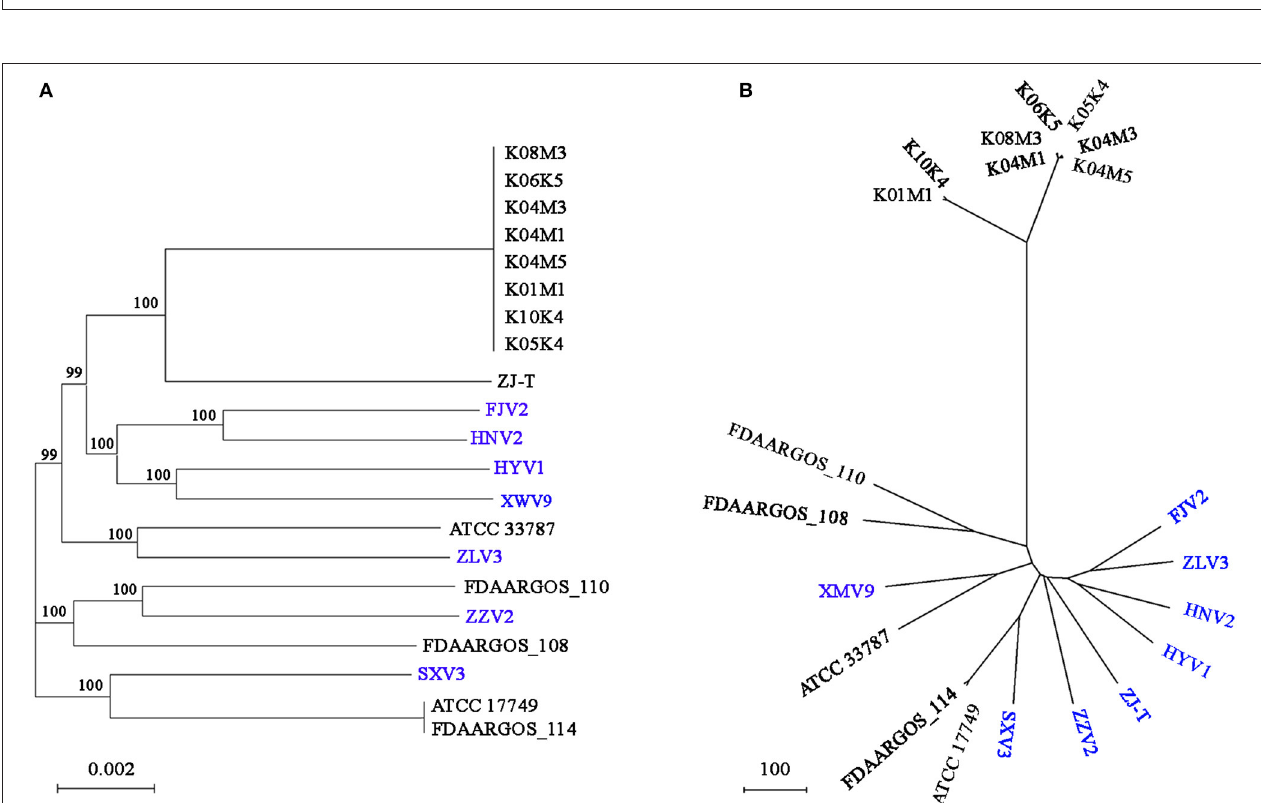
FIGURE 5 | The phylogenomic tree generated based on concatenated alignments of 3854 single-copy core genes among the 21 strains using the ML method. The scale bar indicates the number of substitutions per site (A) . The pan-genome phylogeny constructed based on presence/absence of homologous genes with UPGMA method. The scale bar indicates the distance per 100 genes difference (B) . ML, maximum likelihood; UPGMA, unweighted pair-group method with arithmetic means; branch labels, bootstrap support values.